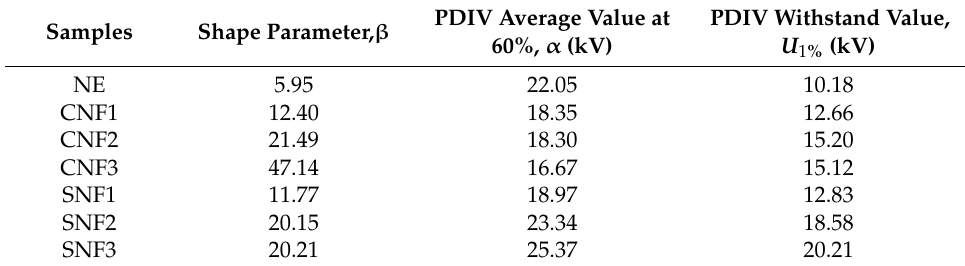
Figure 4. Weibull distribution of PDIV average values for base oil and nanofluid samples. Table 2. Weibull parameters of the average partial discharge inception voltages.